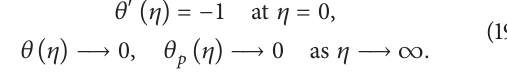
Corresponding thermal boundary conditions